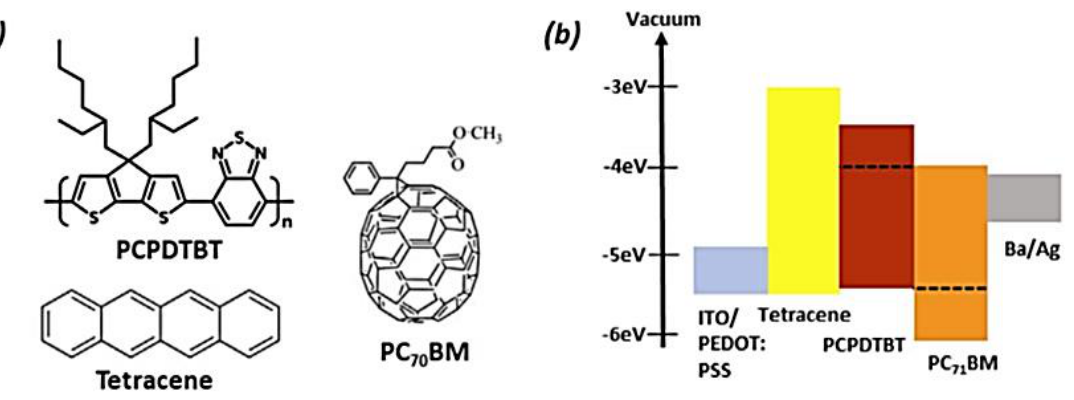
Figure 4. ( a ) Chemical structure of fullerene materials and ( b ) energy-level diagram of a bulk heterojunction device [58]. ITO/PEDOT:PSS = indium tin oxide/poly(3,4-ethylenedioxythiophene):polystyrene sulfonate; PCPDTBT = polycyclopentadithiophene-benzothiadiazole; PC 70 BM = phenyl- C 70 -butyric acid methyl ester; PC 71 BM = phenyl-C71-butyric acid methyl ester. Reproduced with permission from Wiley.